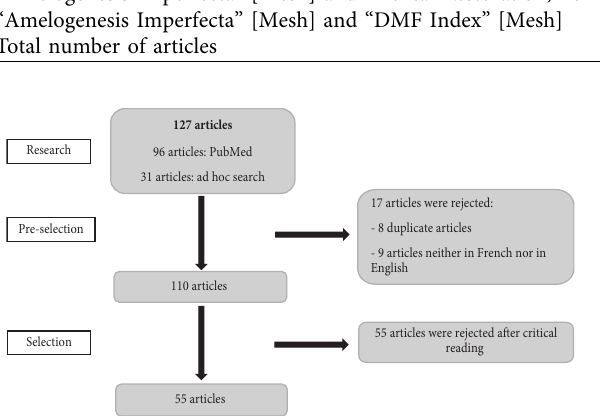
Figure 1: Flow diagram showing the search